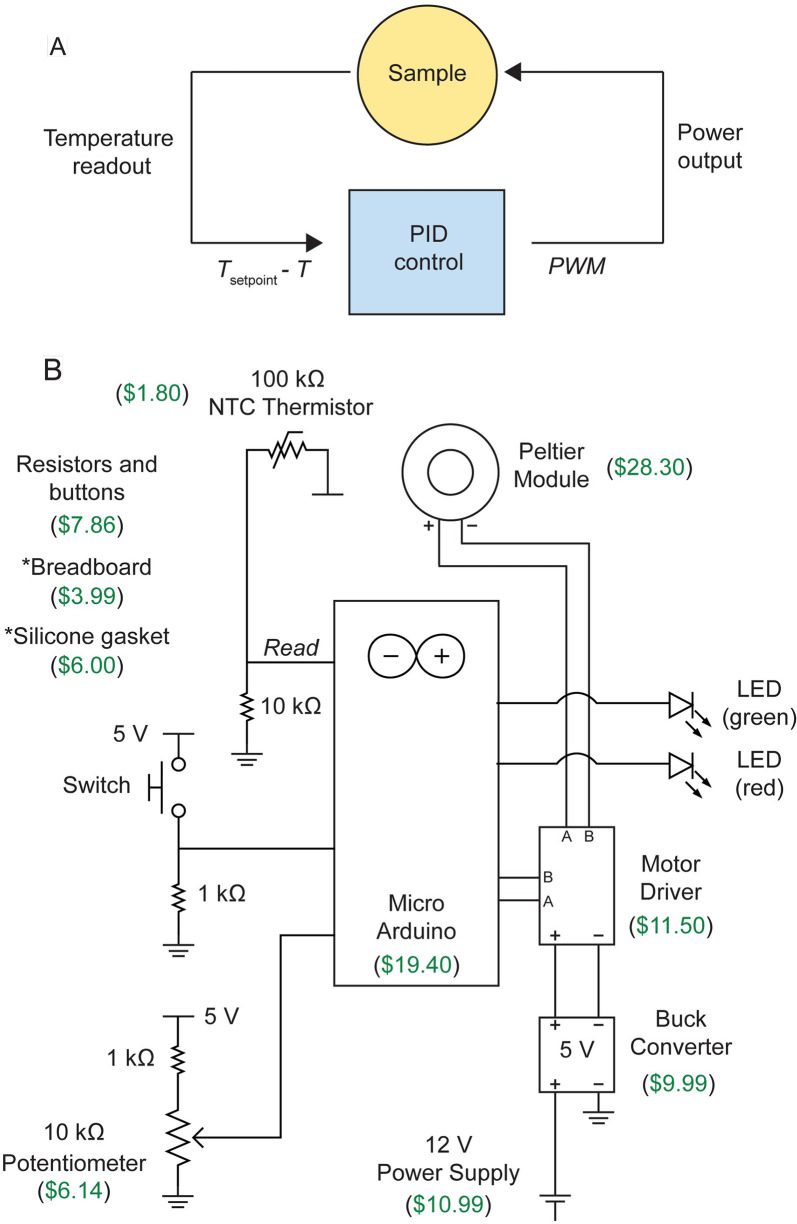
Design of an inexpensive control system.(A) Control design for PID temperature control. The temperature (T) is read by the thermistor at the coverslip, and its difference with respect to the setpoint (Tsetpoint) is used as an input to the PID algorithm. PWM signals are used to modulate the power input to the Peltier module. (B) Circuit design for the temperature-control system. Components are labeled with their estimated itemized price in US dollars. Asterisks indicate items not illustrated in the circuit diagram. The total cost is approximately $106 (S1 Table). LED, light-emitting diode; NTC, negative temperature coefficient; PID, proportional-integral-derivative; PWM, pulse-width-modulation.